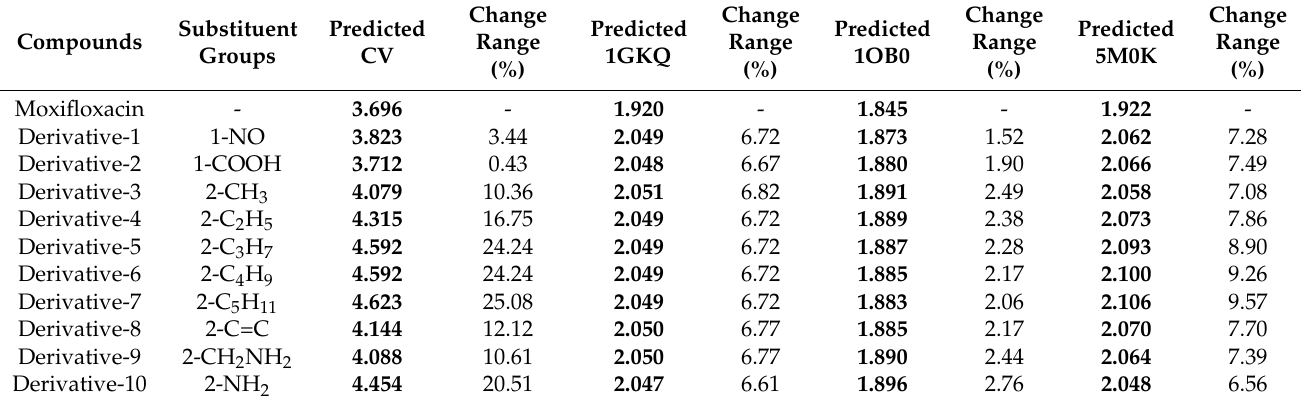
Table 4. The single and comprehensive biodegradation of MOX derivatives.